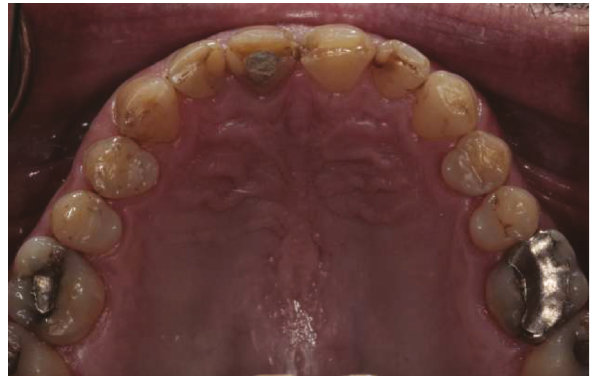
Figure 3: Maxillary occlusal